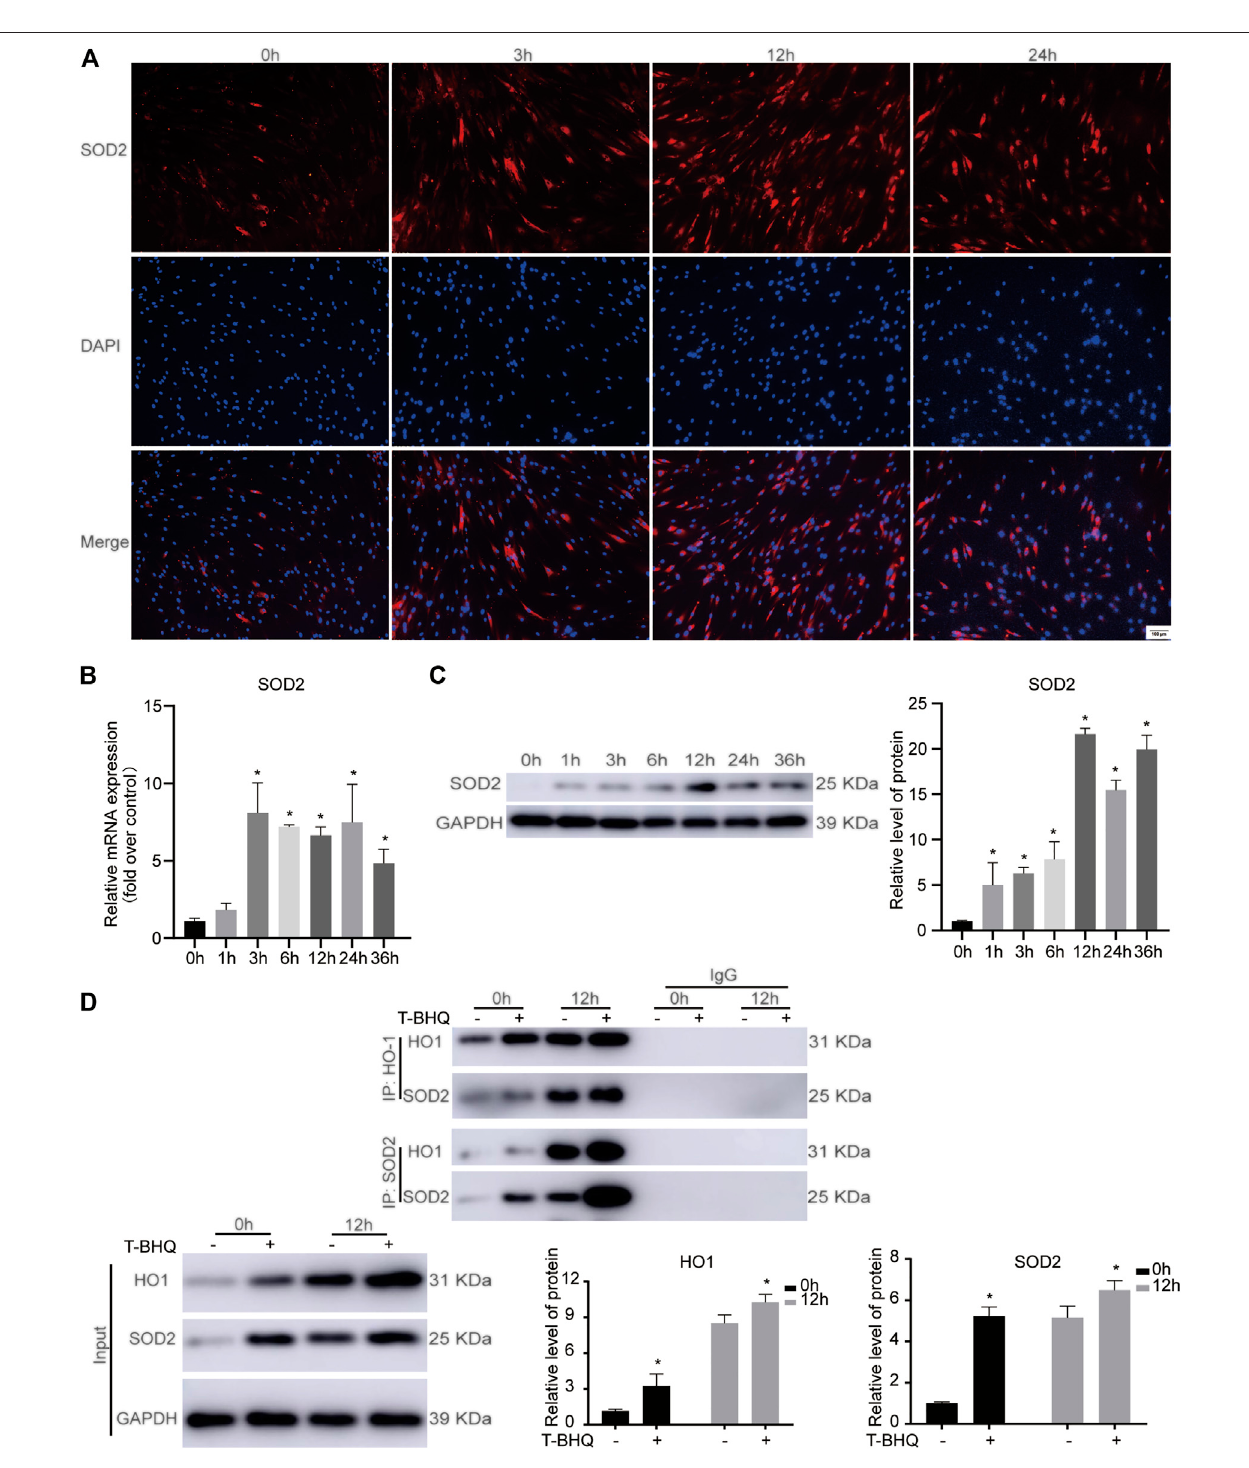
FIGURE 4| The protein-protein interactionbetween HO1 and SOD2 in PDLSCs under cyclic mechanical stress. (A) Immuno fl uorescence stainingof SOD2 during cyclic mechanical stress in PDLSCs. The scale bars, 100 µm. (B) Cyclic mechanical stress up-regulated the SOD2 mRNA expression in PDLSCs, according to the results of RT-PCR. (C) Cyclic mechanical stress promoted the SOD2 protein expression in PDLSCs, according to the results of western blotting. (D) Co-IP experiments showed the protein-protein interaction between HO1 and SOD2 in PDLSCs as immunoprecipitation with anti-HO1 antibody and anti-SOD2 antibody to enrich the protein complex,